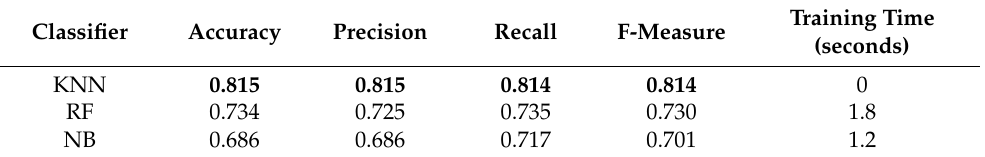
Table 3. Identification results of VGG-19-F6 deep features. Bold values signify the best performance.